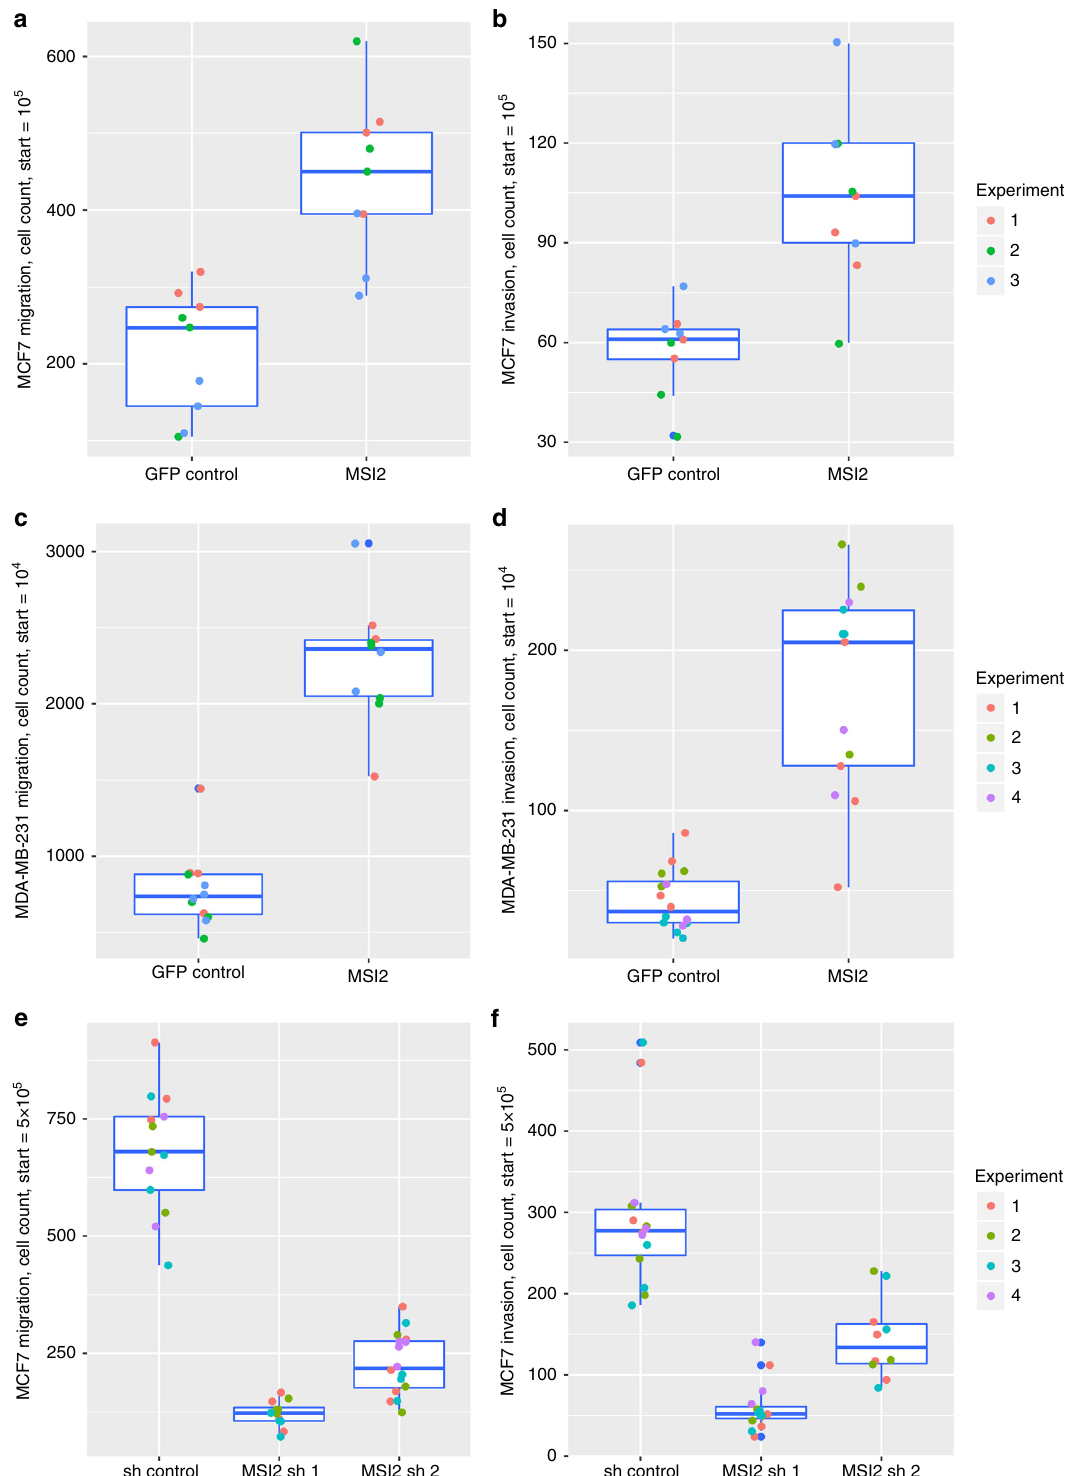
Fig. 4 MSI overexpression increases migration and invasion of MCF7 and MDA-MB-231 MCF7-expressing GFP and MSI2-GFP were counted by Vi-cell-XR, and equally plated on transwells with and without Matrigel. Migration a and invasion b qualities were assessed by counting cells 48 h after initial plating. MSI2 overexpression causes an increase in migration and invasion (Welch ’ s t test; p < 0.05). Box plots of all replicates within each experiment ( n = 3) are depicted. MDA-MB-231-expressing GFP and MSI2-GFP were plated on transwells with and without Matrigel. 48 h after initial plating, the transwells were counted for migration c and invasion d . MSI2 increased both the migrative capabilities and invasive tendencies of MDA-MB-231 (Welch ’ s t test; p < 0.05). As with the MCF7, box plots of all replicates within each experiment ( n = 4) are depicted. Migration e and invasion f were also assayed in MCF7 shRNA control and shRNA MSI2, respectively. The knockdown clones presented the opposite effect, with a signi fi cant decrease in the migration and invasion ability of MCF7 (Welch ’ s t test; p < 0.05). Proliferation assay results are summarised in Supplementary Fig.